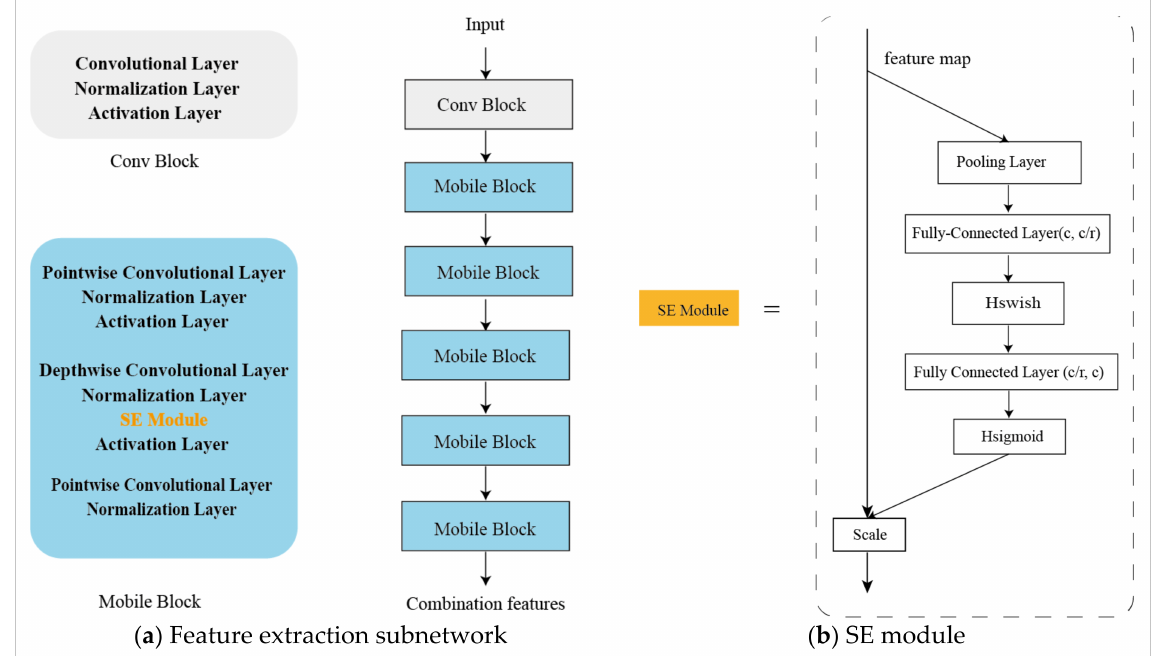
Figure 5. An illustration of the structure of the feature extraction subnetwork ( a ) and the SE (Squeeze and Excitation) module ( b ). The feature extraction subnetwork consists of a conv block and a mobile